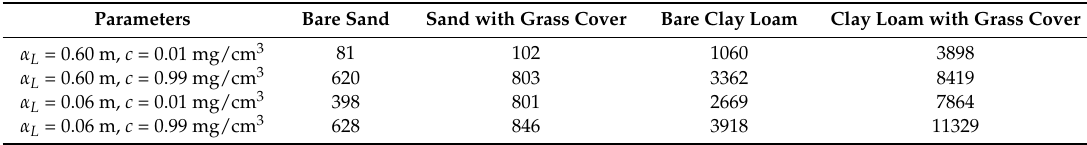
Table 3. Estimates of travel time (days) from numerical simulations of transient